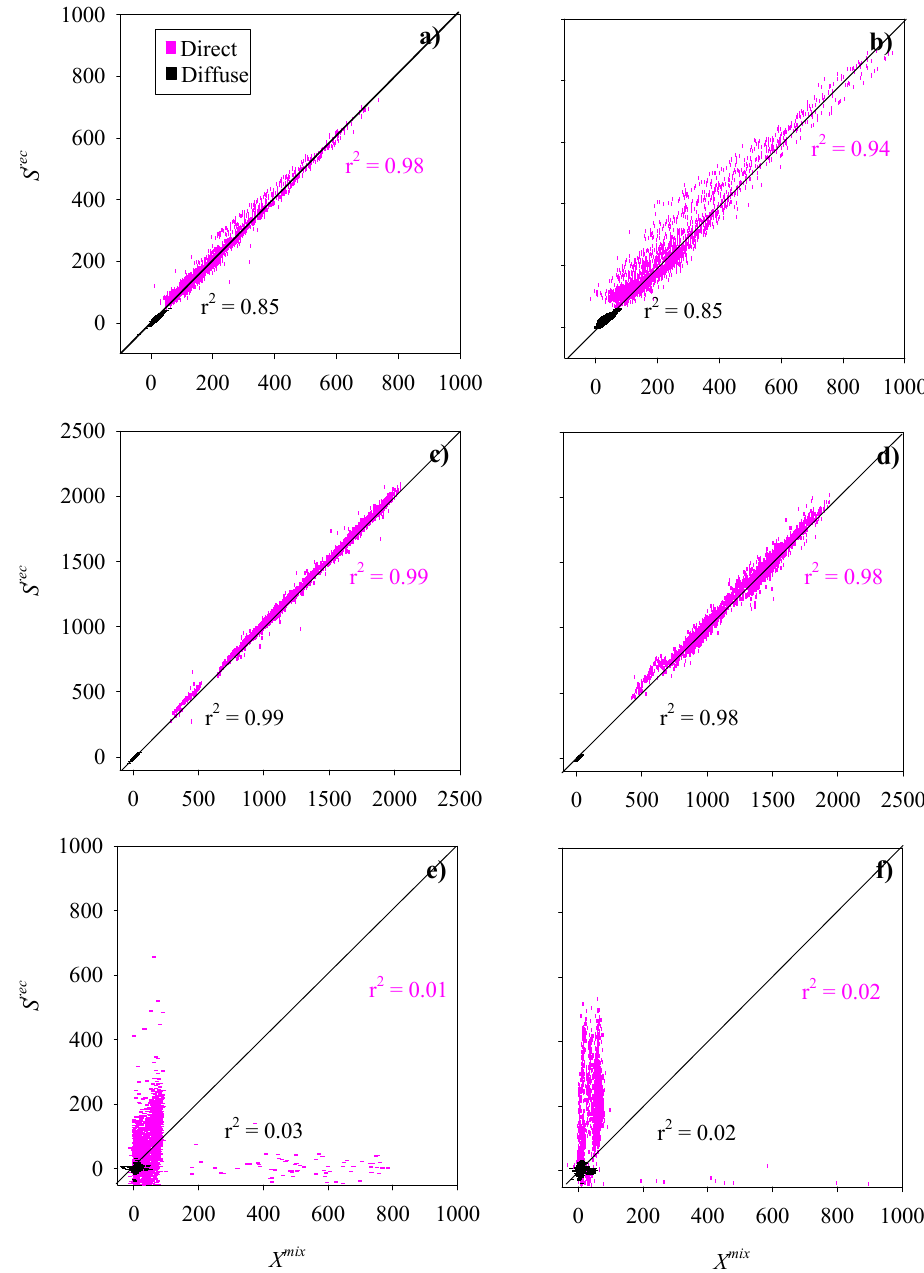
Figure 4. Reconstructed S sources. λ = 473 nm ( left panels ), λ = 532 nm ( right panels ), time bin 110 ( top panels , a , b ), 160 ( middle panels , c , d ) and 270 ( bottom panel , e , f ); 1:1 relationships (solid line), r 2 for direct (magenta) and diffuse (black) ICA components.